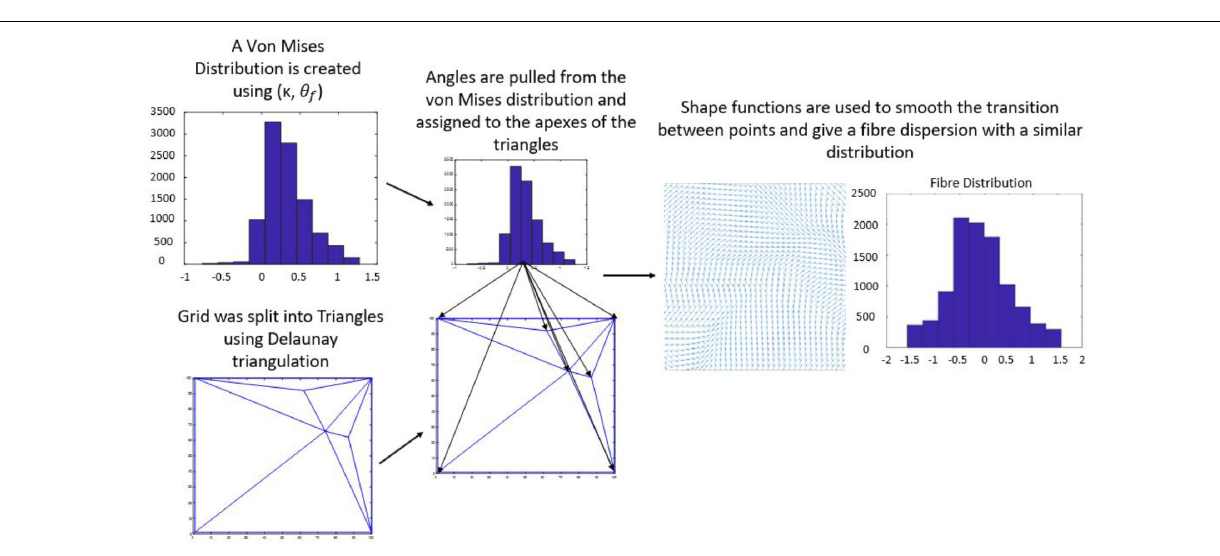
FIGURE 4 | Flow chart demonstrating workflow used to create a fiber